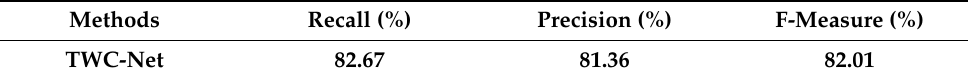
Table 1. Recall, precision, and F-measure of TWC-Net in VOC2007 (IOU = 0.5). Methods